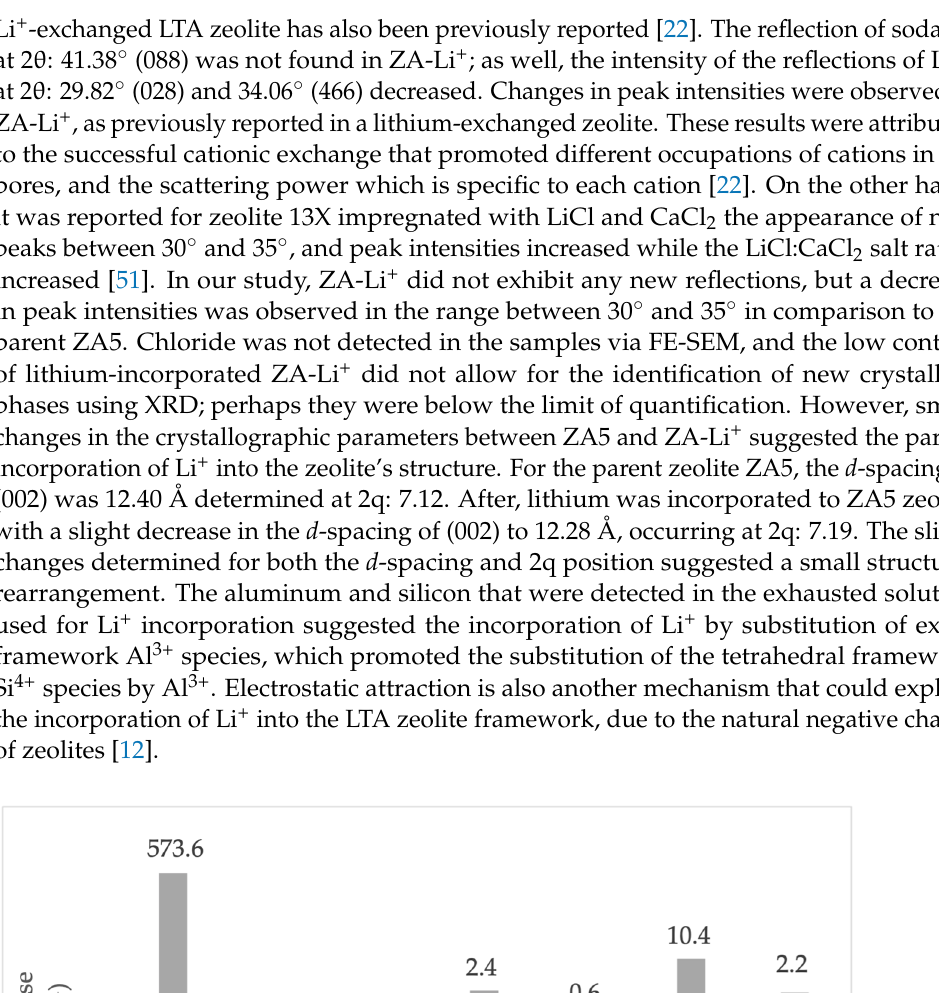
Table 4. Chemical composition of the synthesized ZA5 and modi fi ed zeolite ZA-Li + .